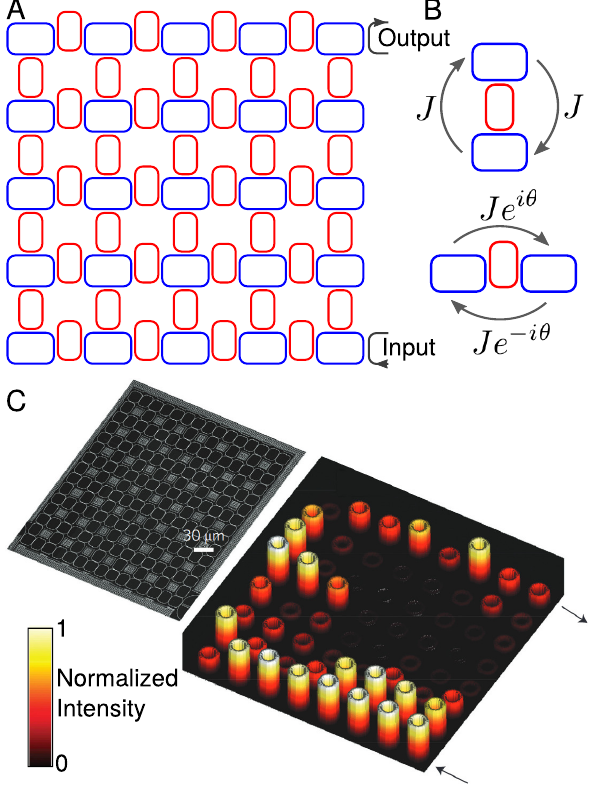
Figure 3: Synthetic magnetic field in a ring resonator lattice. (A) Schematic of lattice, consisting of resonant “ site ” rings (blue) coupled via antiresonant “ link ” rings (red). Light is injected at the input into anticlockwise-circulating site modes, effectively breaking time-reversal symmetry.(B)Schematicof couplingterms in the tight bindingHamiltonian.Couplingintheverticaldirectionissymmetric, while coupling in the horizontal direction is accompanied by a hopping phase e ± i θ due to the asymmetry of the link ring. An inho- mogeneous hopping phase θ = α y induces a synthetic magnetic fl ux α . (C) Image of the fi rst photonic topological resonator lattice and propagation of its edge states, adapted from the study by Hafezi et al.